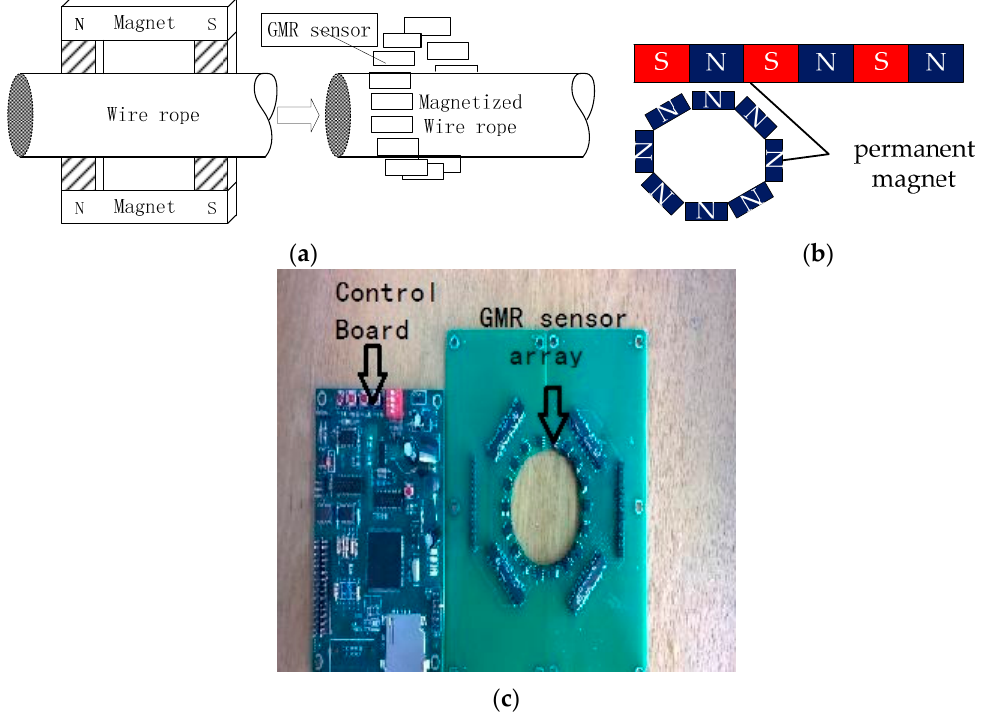
Figure 1. ( a ) Framework of the detection device and detection method diagram; ( b ) Excitation source; and ( c ) Signal acquisition system board.